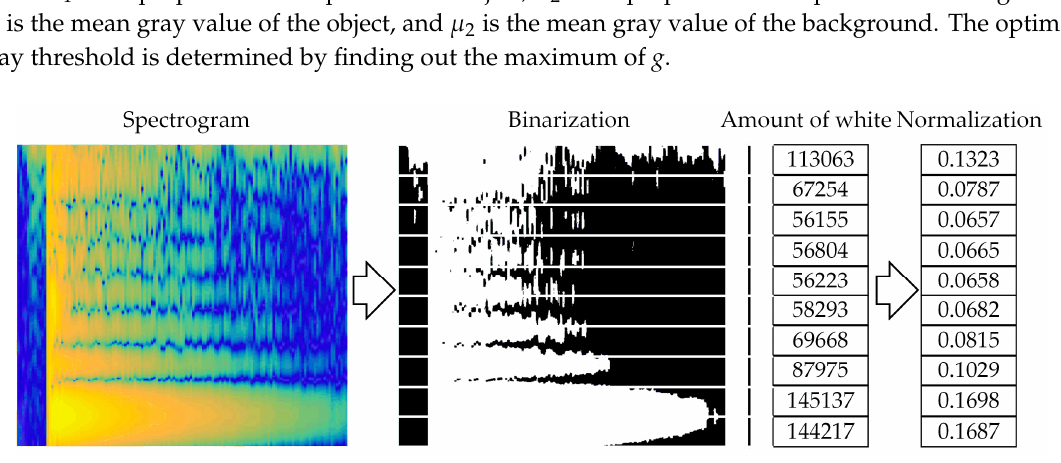
Figure 6. Progress of binarization and feature extraction.